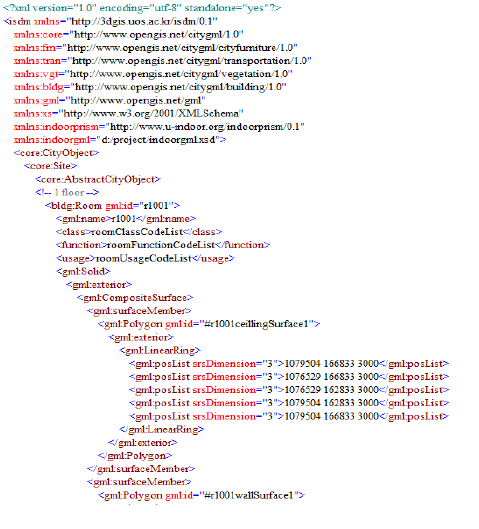
Figure 8. A sample XML data